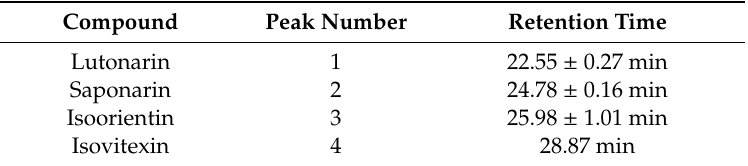
Table 1. The four flavonoids which are identified in the aerial parts of Bryonia